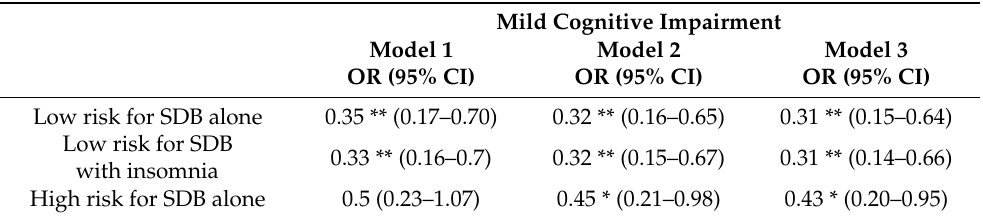
Table 3. Associations between sleep disorder groups and MCI with high risk for SDB with insomnia as